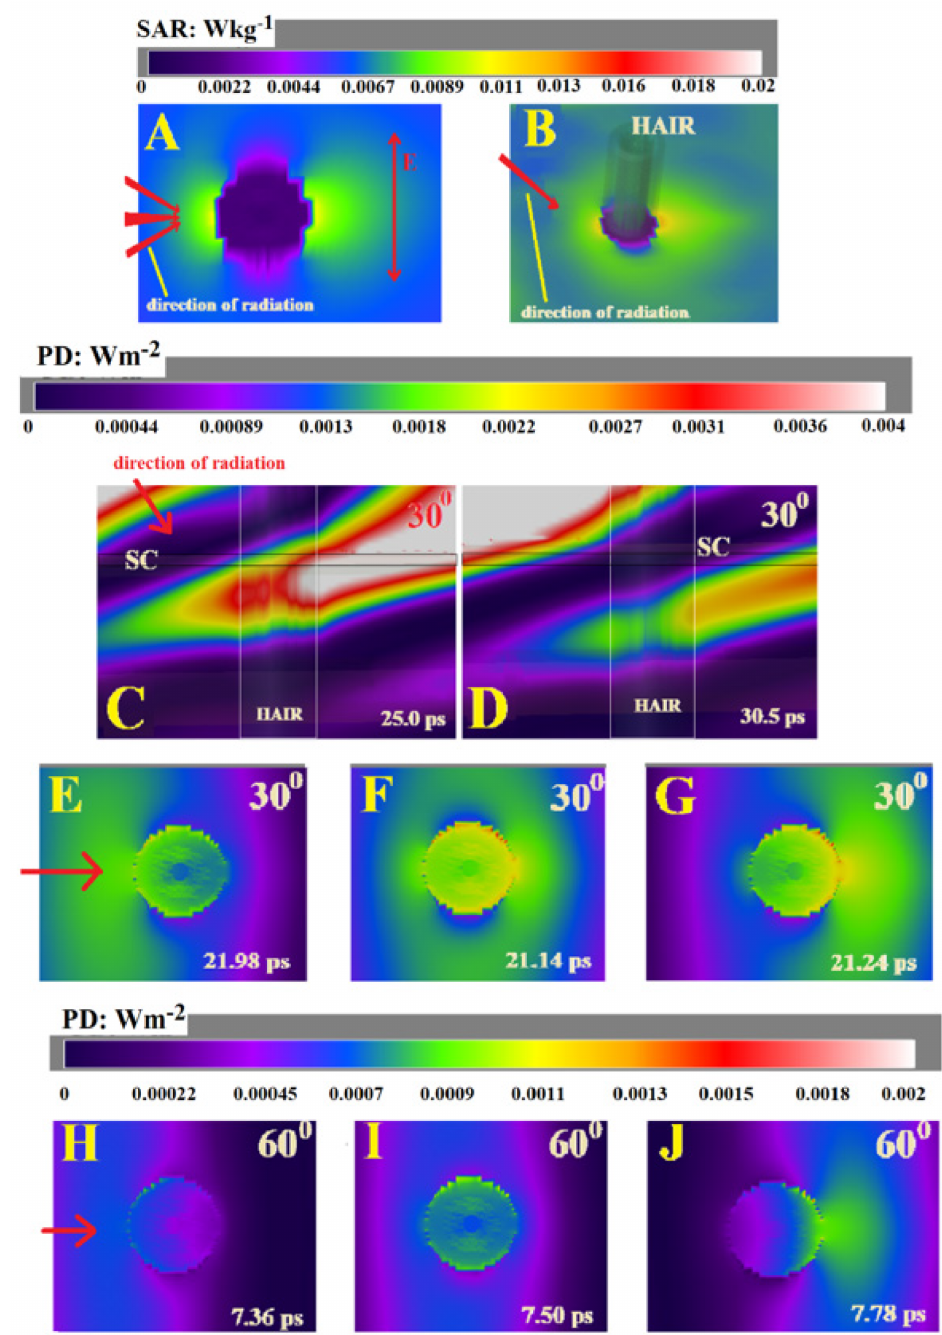
Figure 4. E-field direction as shown in ( A ), direction of the incoming radiation shown by the red arrows. ( A ) Horizontal cross-section, SAR distribution at 0.05 mm, θ i = 30 ◦ . ( B ) A three-dimensional complex hair view. ( C , D ) Vertical cross-section, PD progression, θ i = 30 ◦ , excitation from upper left, complex hair. The position of the SC and the hair shaft are shown. ( E – G ) Horizontal section, PD progression, θ i = 30 ◦ , excitation from left. ( H – J ) Horizontal cross-section, PD progression, θ i = 60 ◦ , excitation from left. The frames demonstrate the asymmetrical distribution of PD and SAR surrounding the hair, which changes with the incident angle. The pattern is due to the interaction of reflection and the traveling and evanescent wave formation in the hair